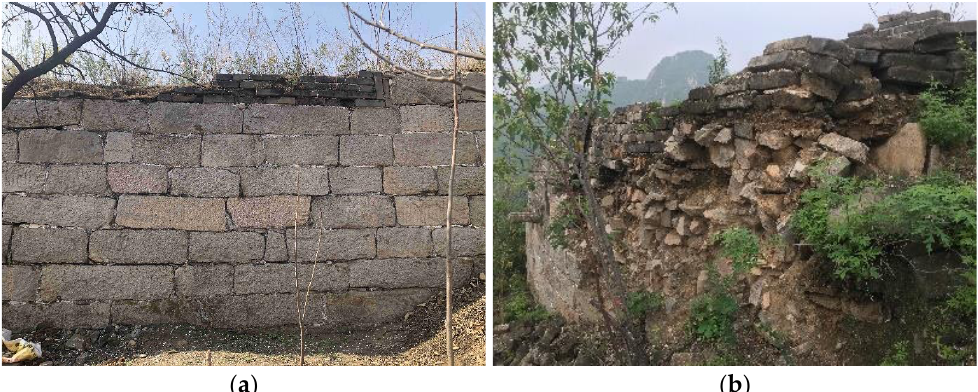
Figure 6. Flat section of the Great Wall: ( a ) Normal stone layer of the base wall; ( b ) Stone layer collapse.